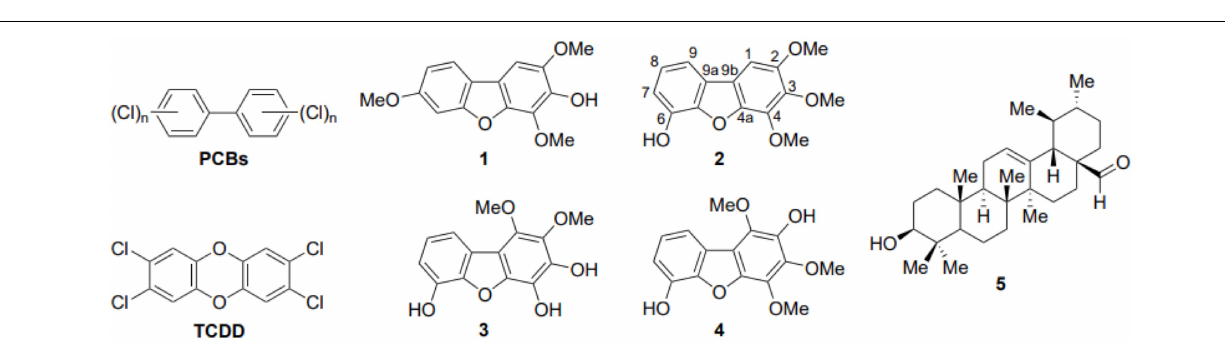
FIGURE 3 | Structures of polychlorinated biphenyls (PCBs). 2,3,7,8-tetrachlorodibenzo- p -dioxin (TCDD) and the five compounds employed in this study. Compounds 1–4 are the dibenzo- p -furan derivatives isolated from the total C. pycnoloba extract, including the atom numbering of the newly discovered compound 2 . Compound 5 is ursolic aldehyde, isolated from the active fragments of C. pycnoloba but has no melanin synthesis inhibition